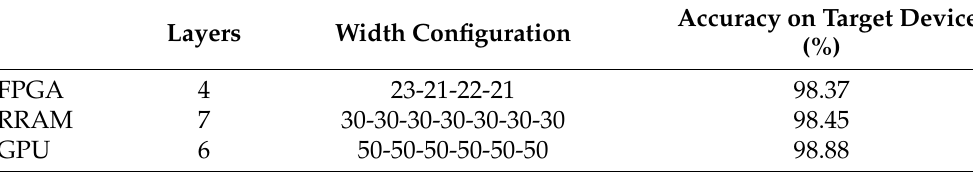
Table 12. Optimal BNN models for different